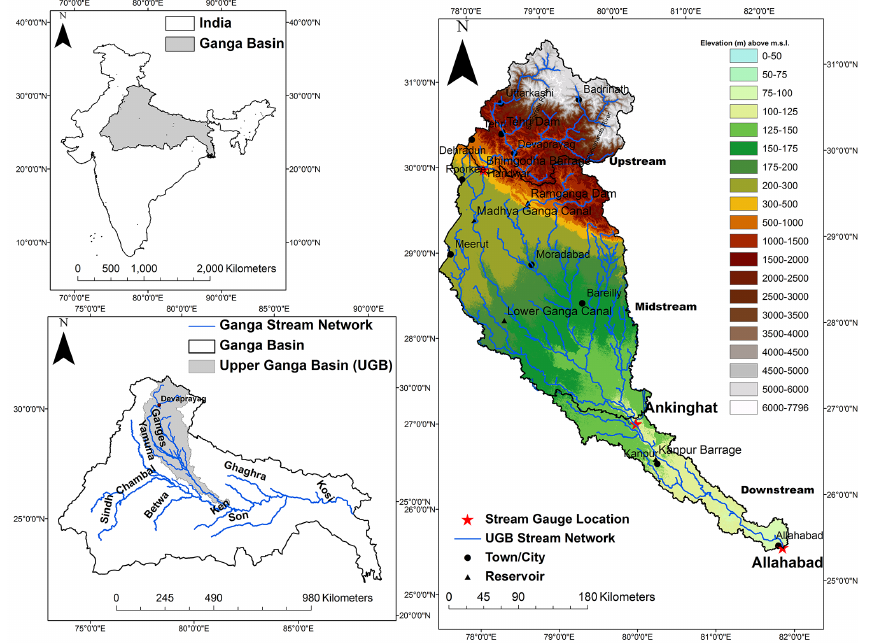
Figure 1. Location map and details of the